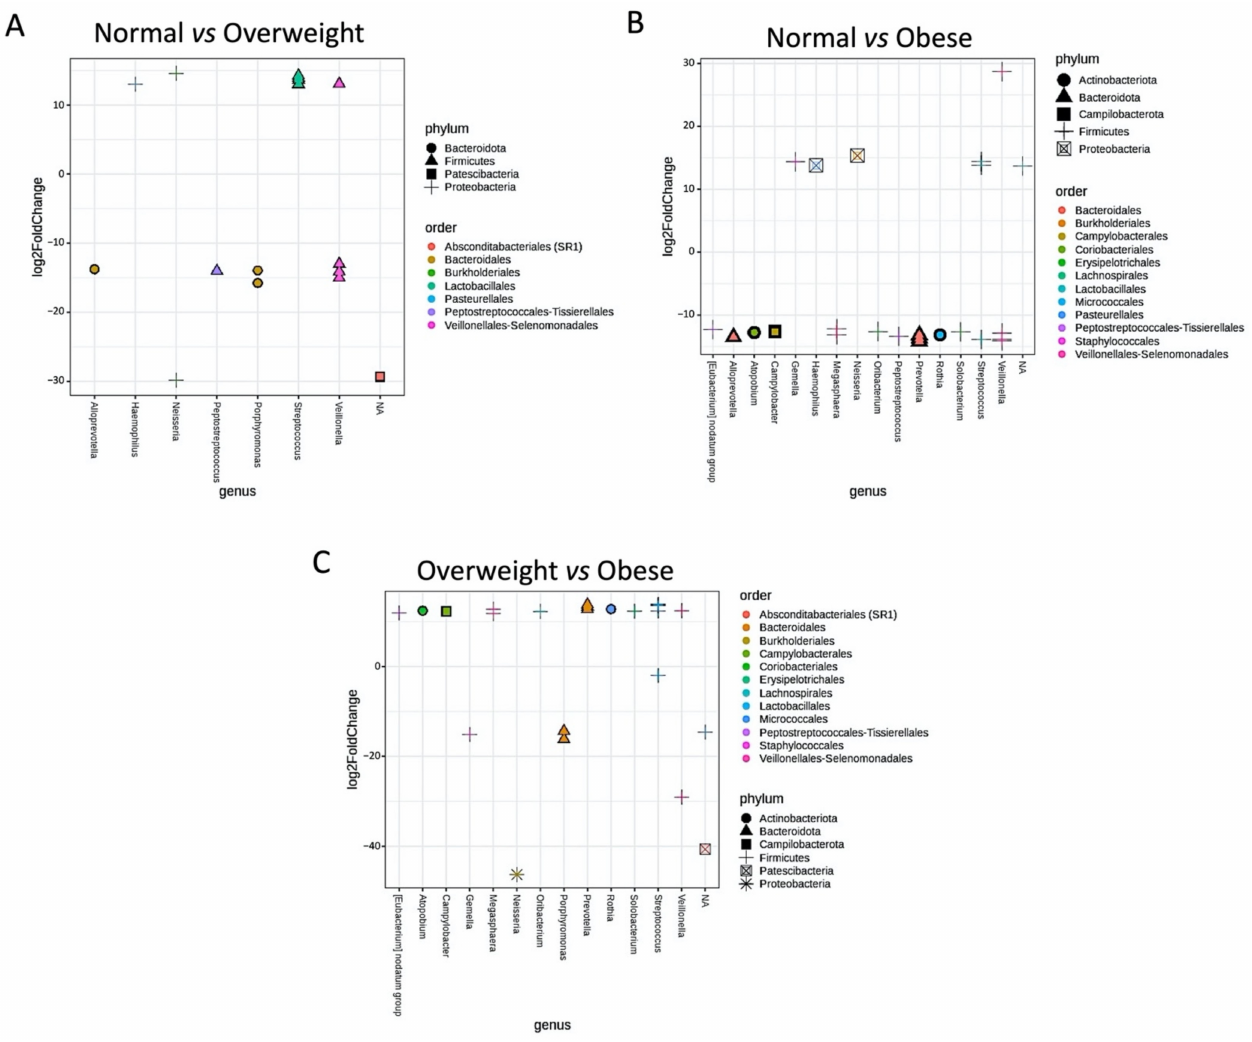
Figure 5. The scatter plots illustrating the differential abundance of core microbial taxa between different BMI groups. ( A ) Normal vs. overweight; ( B ) normal vs. obese; ( C ) overweight vs.